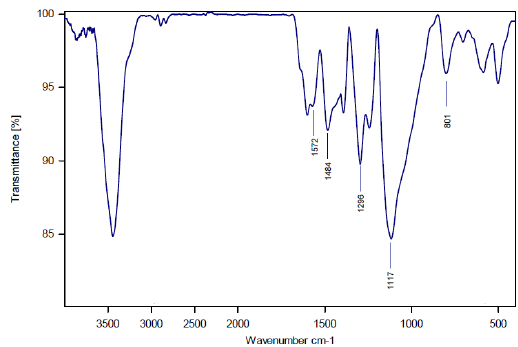
Fig. 2. Fourier Transform Infrared Spectroscopy of Polyanilinenano-adsorbent